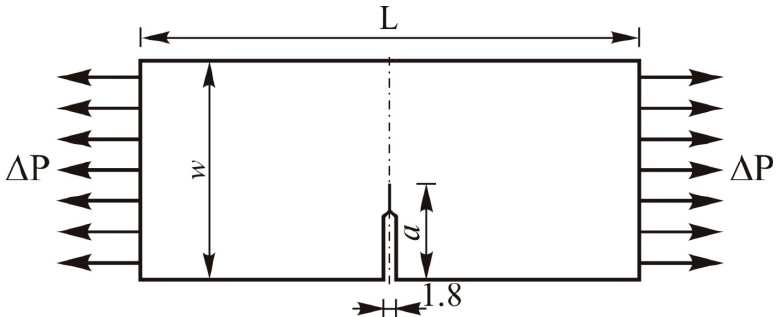
Figure 1. Geometry of the plate with edge crack-like flaw subjected to cyclic loading with overload (unit: mm).